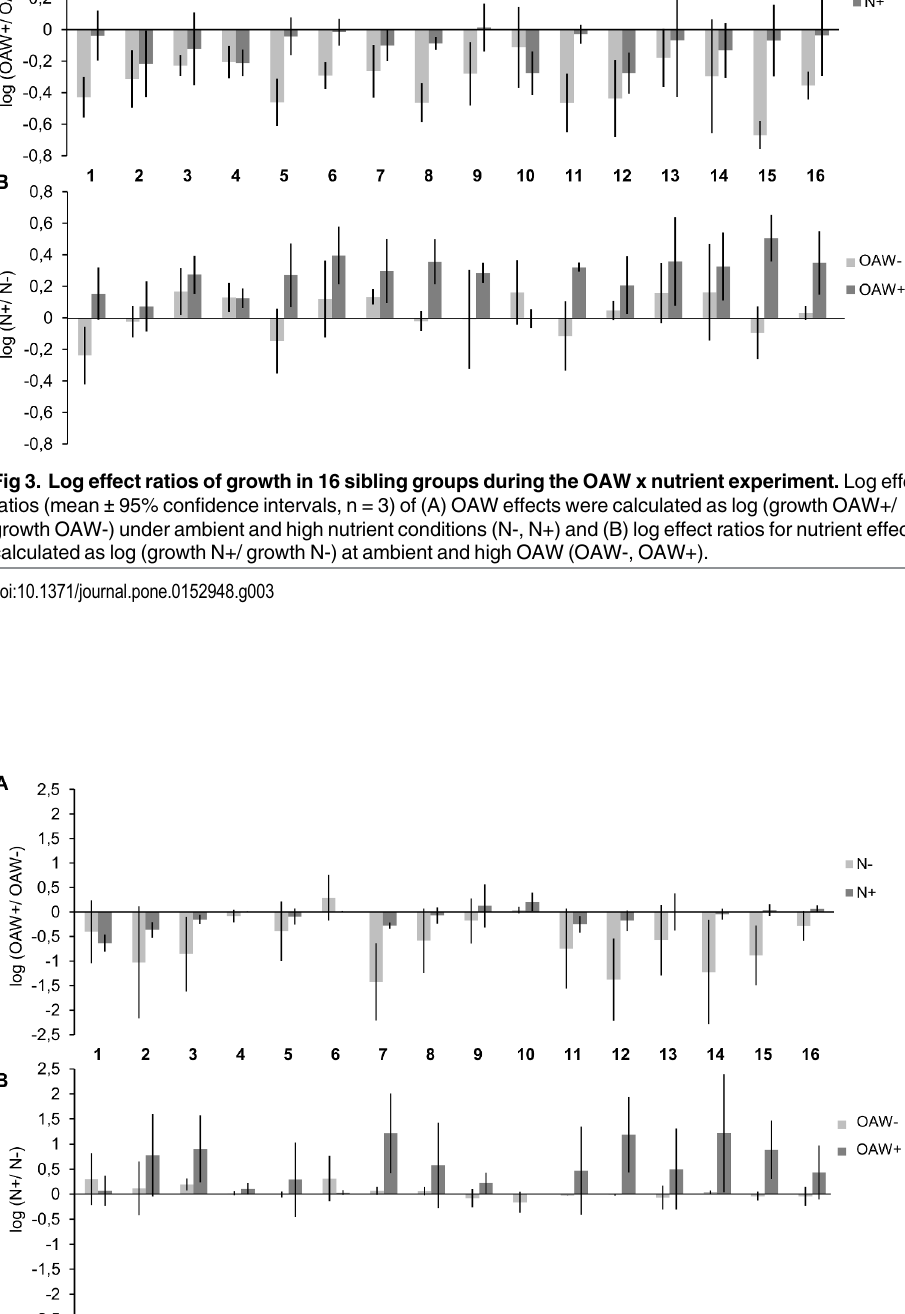
PLOS ONE | DOI:10.1371/journal.pone.0152948 April 4,